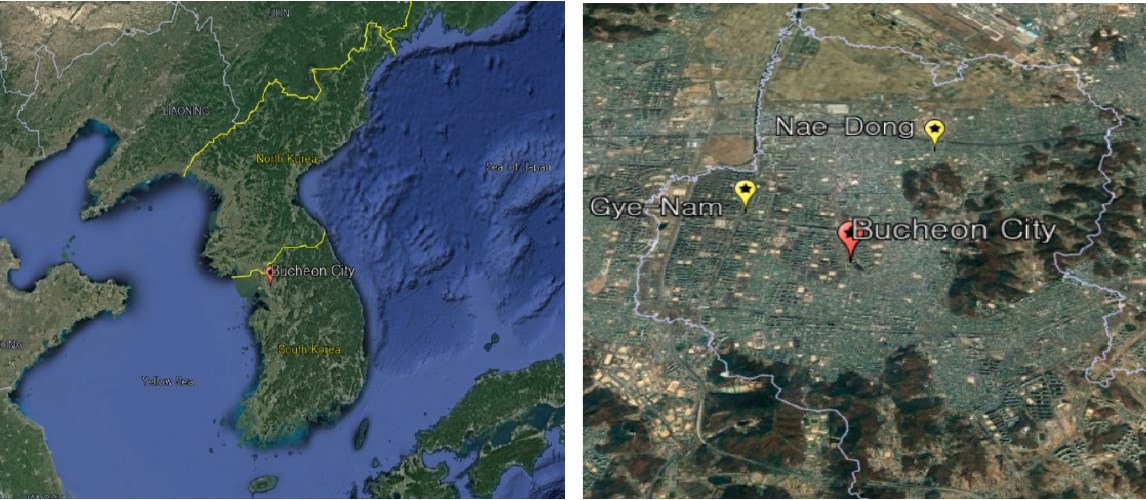
Figure 1. Locations of the study area and sampling points.